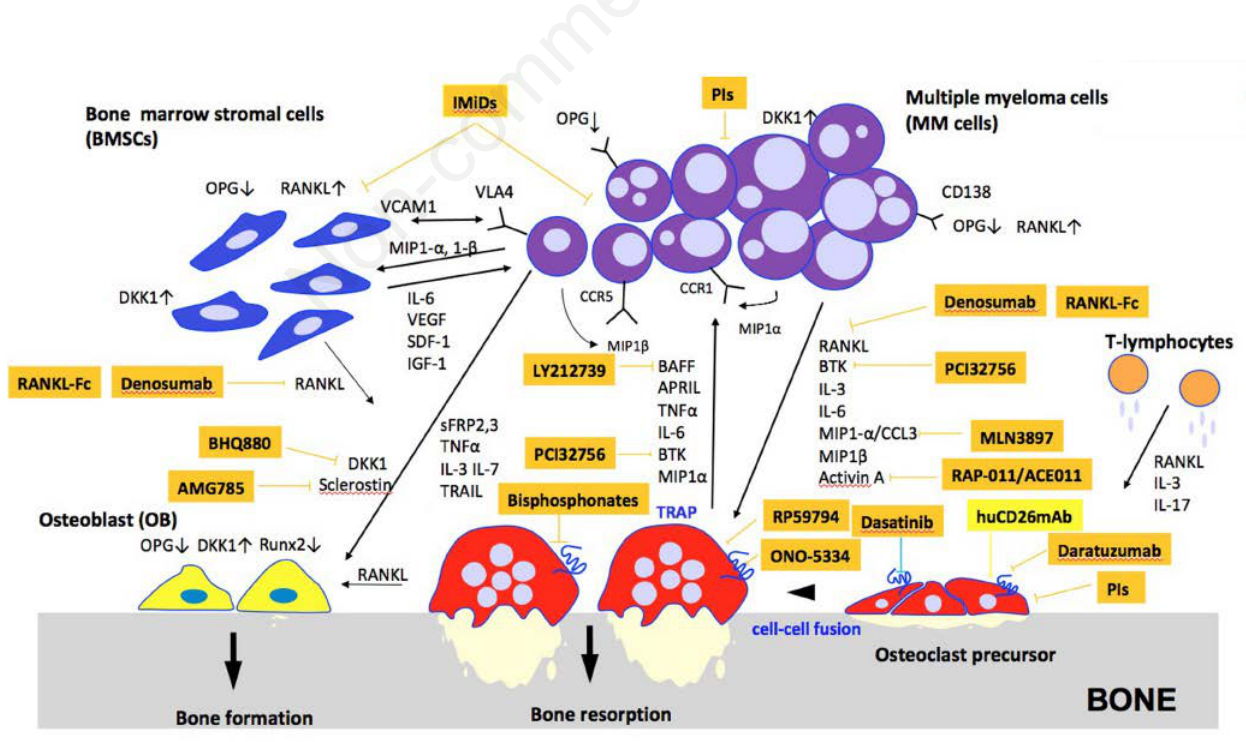
Figure 1. Vicious cycle of multiple myeloma-associated bone